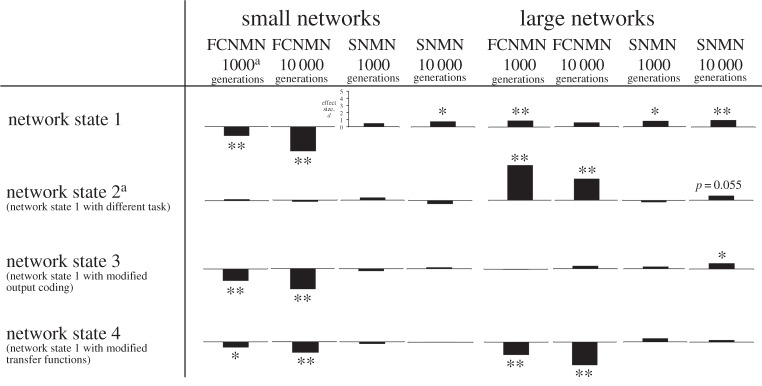
A summary of all data in figures 1–5, with comparisons between the PMN and each of the non-modular networks (FCNMN and SNMN) expressed as an effect size, d, calculated as equations 1 and 2 of [18]. Positive effects, in which the modular network performs better that the other network types, are plotted with bar upwards and negative effects are shown with a downwards plotted bar. The statistical significance of effects calculated using the t-test is shown above or below bars. * indicates 0.05 < p < 0.01, ** indicates p < 0.01 and absence of an asterix indicates p > 0.05. Statistics associated with these probabilities can be found in the captions of figures 1–5. Superscript a denotes that in network state 2, performance was gauged at 15 and 500 generations rather than 1000 and 10 000 generations because the task was easy and networks achieved high fitness values rapidly. y-axis scale, which is the same in each graph, is shown only in one instance.